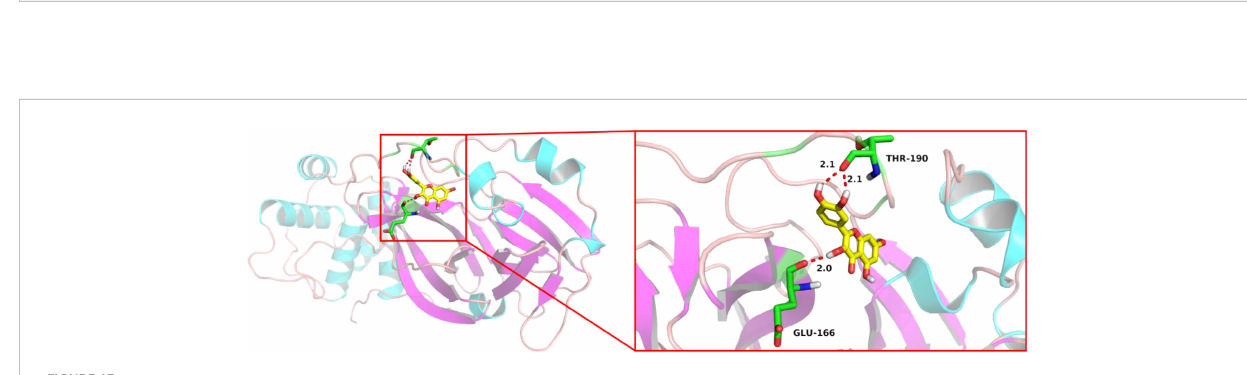
FIGURE 13 Schematic diagram of molecular docking between quercetin and